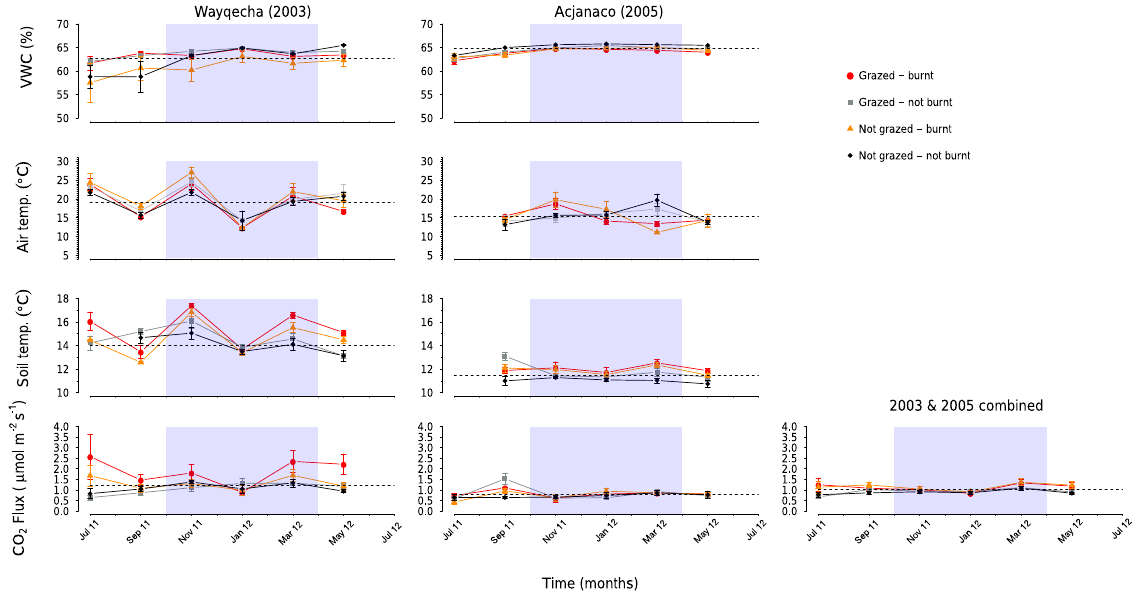
Figure 3. Monthly soil temperature (5cm), air temperature, soil VWC (0–10cm) and soil CO 2 flux from grazed and non-grazed subplots on sites burned in 2003 (Wayqecha) and 2005 (Acjanaco) as well as adjacent non-burnt sites in the montane grassland. The graph on the right represents the mean CO 2 flux of both burnt sites combined. For CO 2 fluxes, each symbol is a mean of four chambers with morning and afternoon measurements combined, and standard errors ( n = 8) are plotted as error bars. The dotted line represents the mean for that site and the blue band represents the wet season (October–March). Table 3. Mean soil C content (Mg Cha − 1 ) for each depth and total C stocks (0–30 and 0–20cm) on all the land management systems. Different letters down the columns within each depth represent significant differences among sites. All values are given with 1 standard error of the mean ( n =